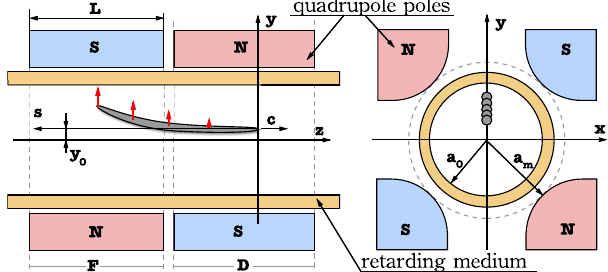
FIG. 1. A schematic diagram of the CWA embedded in the FD channel and the electron bunch propagating from the left to